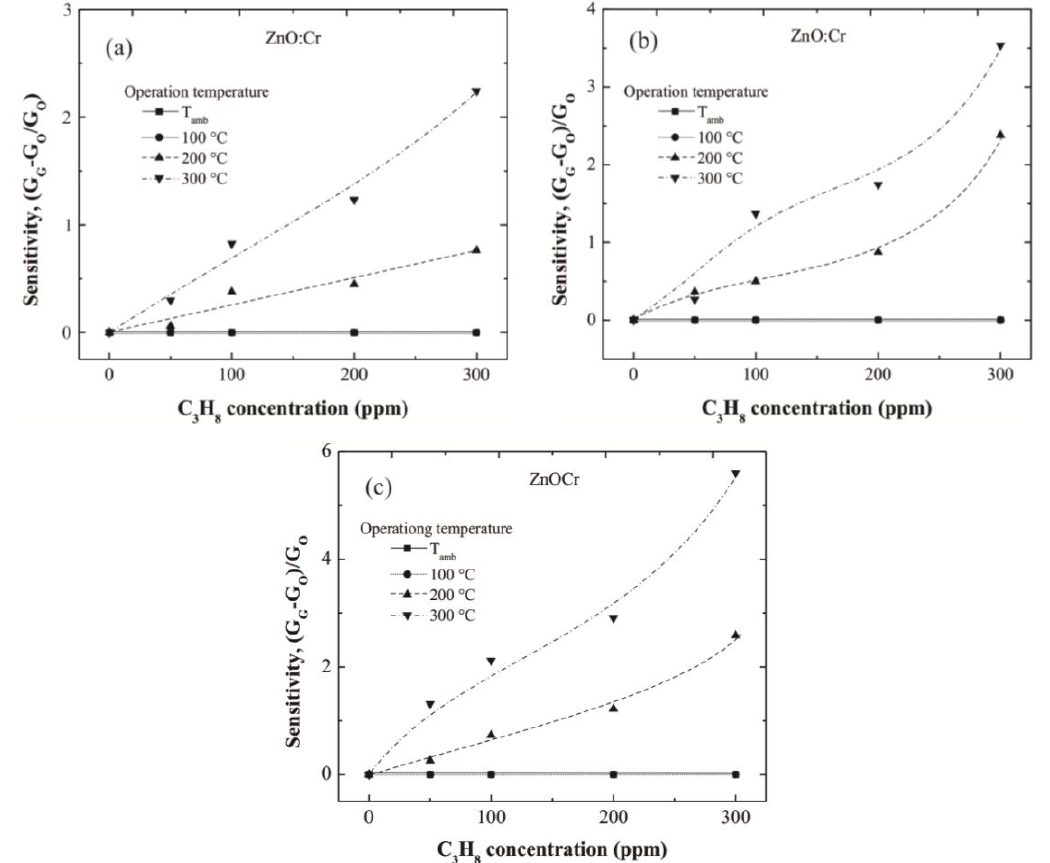
Figure 6. Sensitivity as a function of C Cr content, ( a ) one, ( b ) three, and ( c ) five immersions; measured at room temperature, 100, 200 and 300 °C.